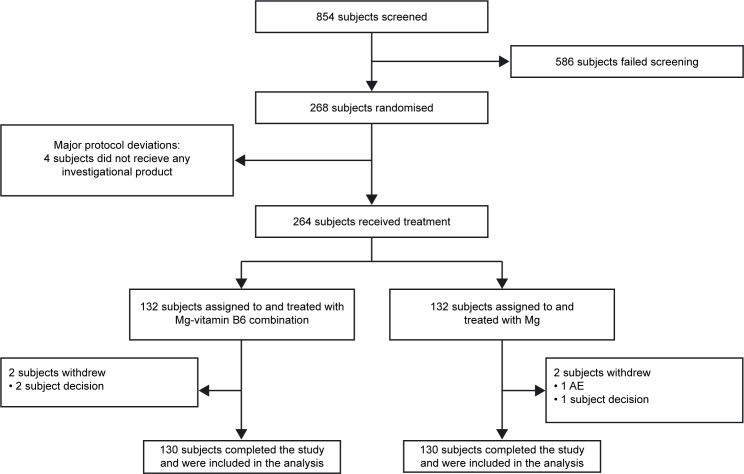
CONSORT flowchart.AE, adverse event; Mg, magnesium.